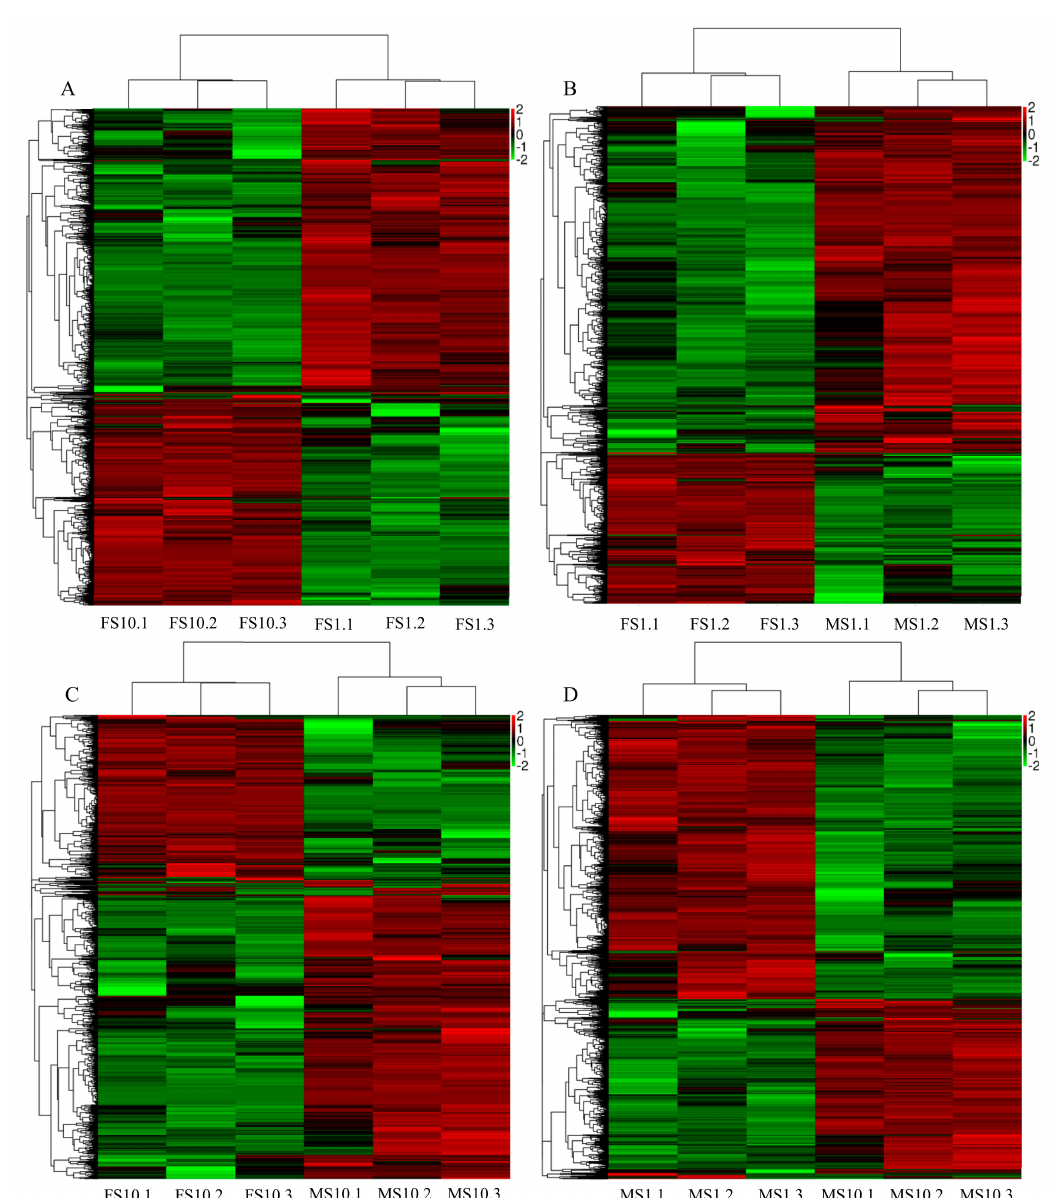
Figure 3. Heatmap visualization of expression profiles of MS1, MS10, FS1 and FS10. ( A ) Heatmap visualization of expression profiles between FS1 and FS10. ( B ) Heatmap visualization of expression profiles between FS1 and MS1. ( C ) Heatmap visualization of expression profiles between FS10 and MS10. ( D ) Heatmap visualization of expression profiles between MS1 and MS10. Red arrow, > two-fold up-regulation; green arrow, > two-fold